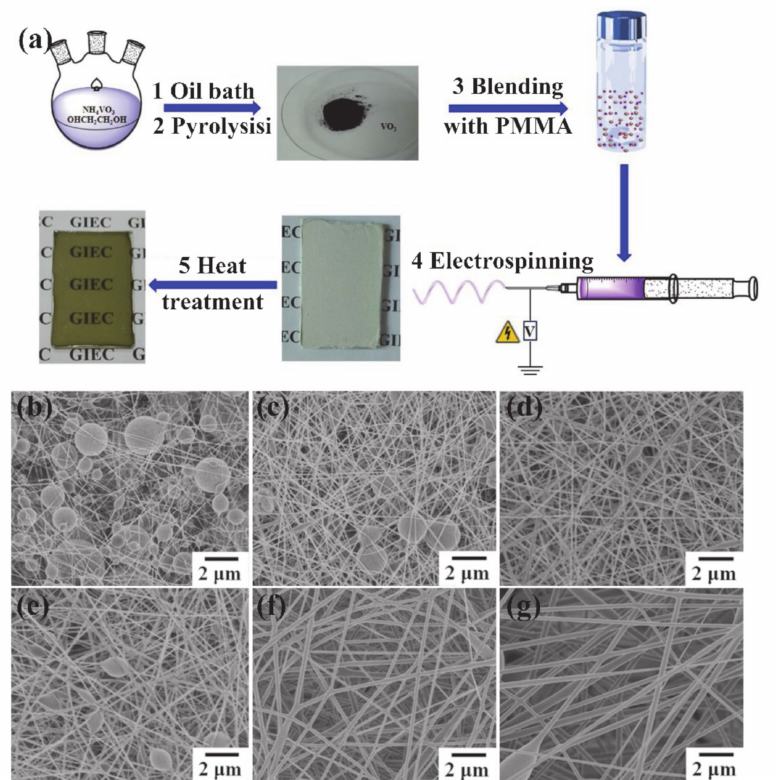
Figure 17. ( a ) Schematic diagram of the fabrication process of the VO 2 film via electrospinning technique. ( b – g ) SEM images of the PMMA nanofibrous mats with different concentration ( w / w ): ( b ) 10%, ( c ) 12%, ( d ) 14%, ( e ) 16, ( f ) 18% and ( g ) 20%. Reproduced from [42], with permission